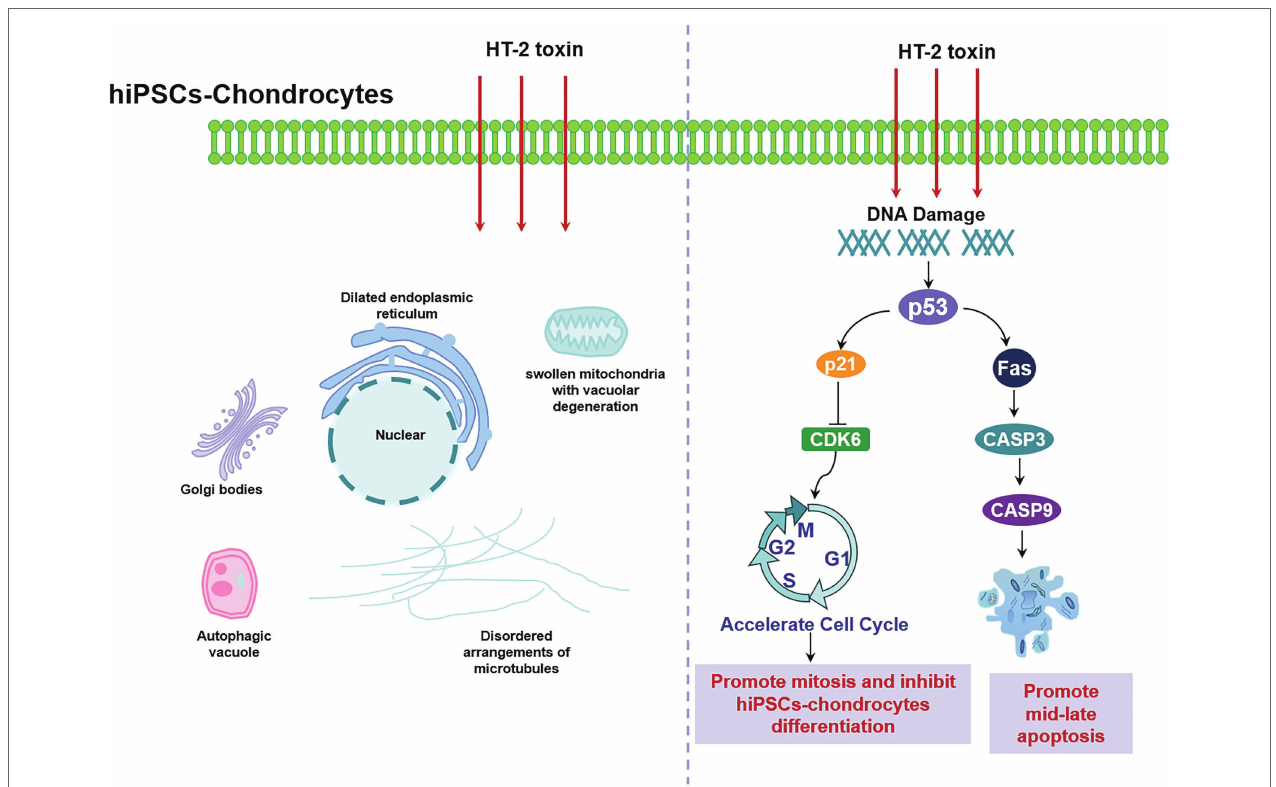
FIGURE 7 | Schematic illustration of HT-2 toxin damaged the differentiating hiPSC chondrocytes by damaging cellular ultrastructure, dysregulating cell cycle, and increasing cell apoptosis through p53. hiPSC, human induced pluripotent stem